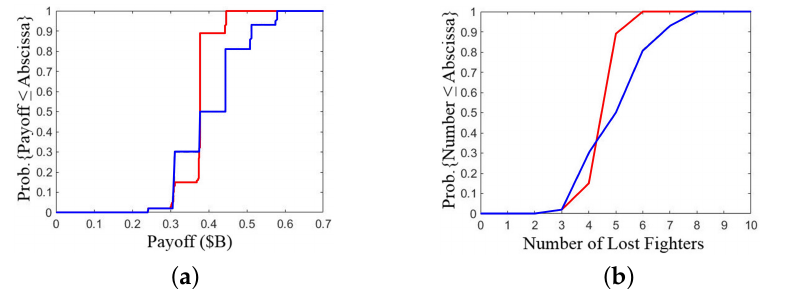
Figure 9. (A1/B1) Cumulative distribution of ( a ) payoff, ( b ) lost fighters, with one P 2 SO run over 100 games, ———: fleet A, ———: fleet